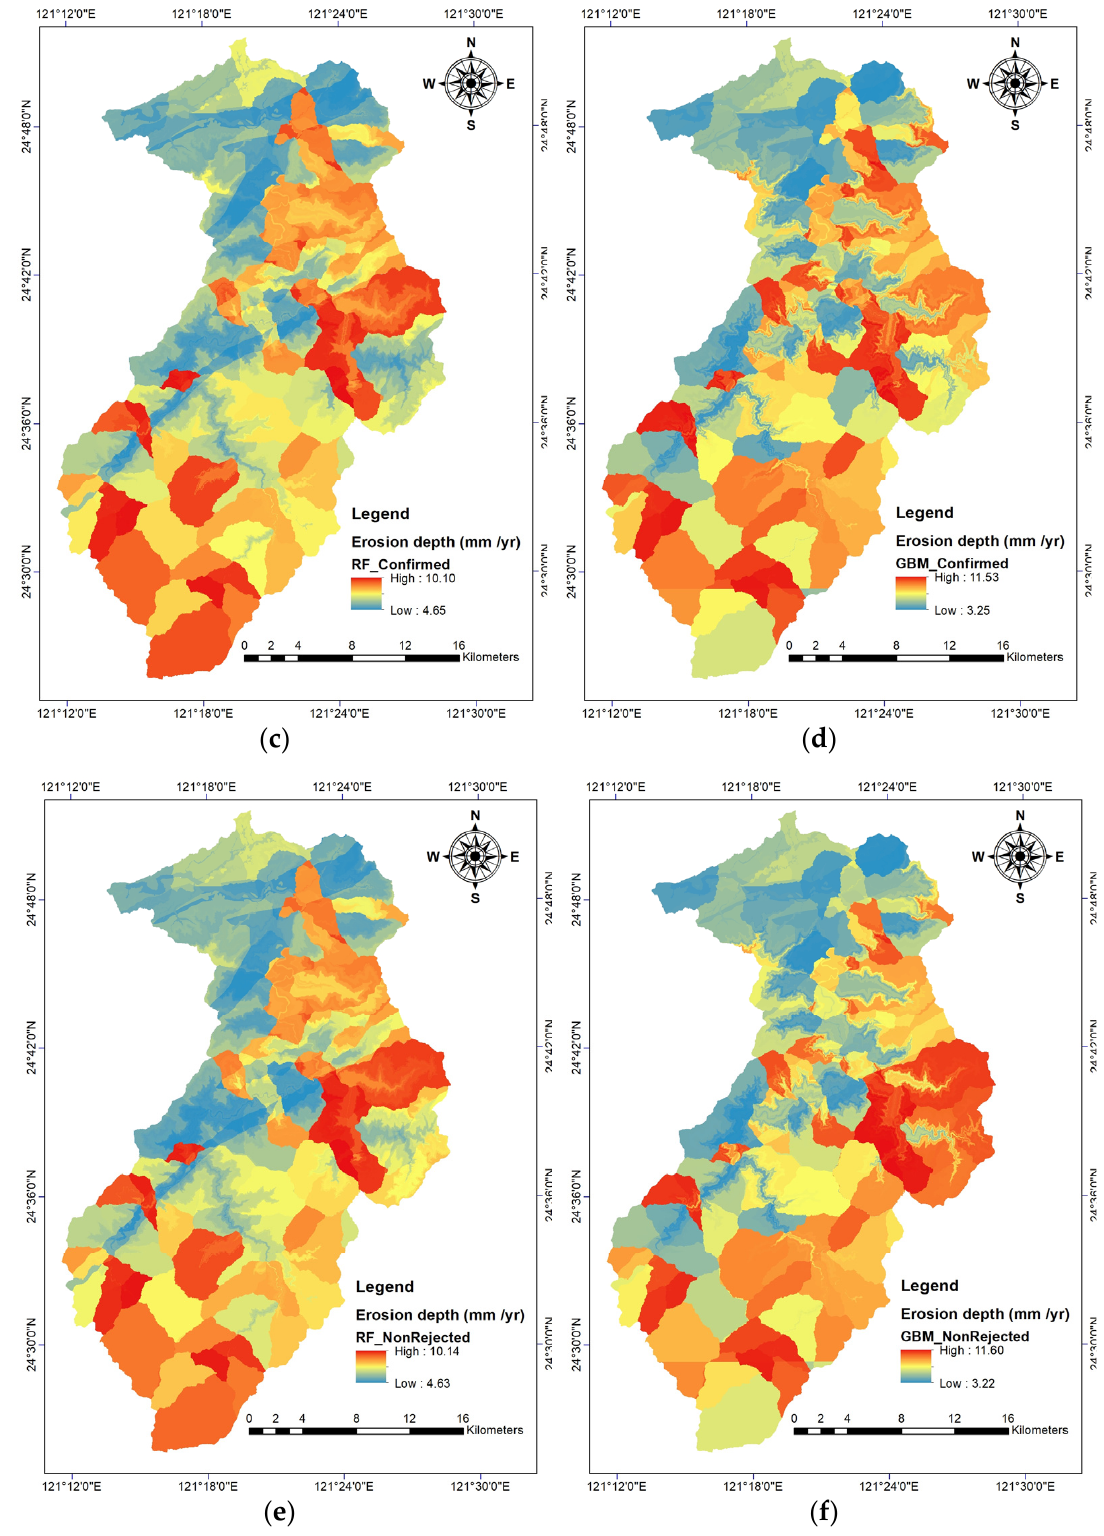
Figure 7. Prediction of soil erosion depth of the entire Shihmen Reservoir watershed using machine learning: ( a ) RF (all), ( b ) GBM (all), ( c ) RF (confirmed), ( d ) GBM (confirmed), ( e ) RF (nonrejected), and ( f ) GBM (nonrejected).